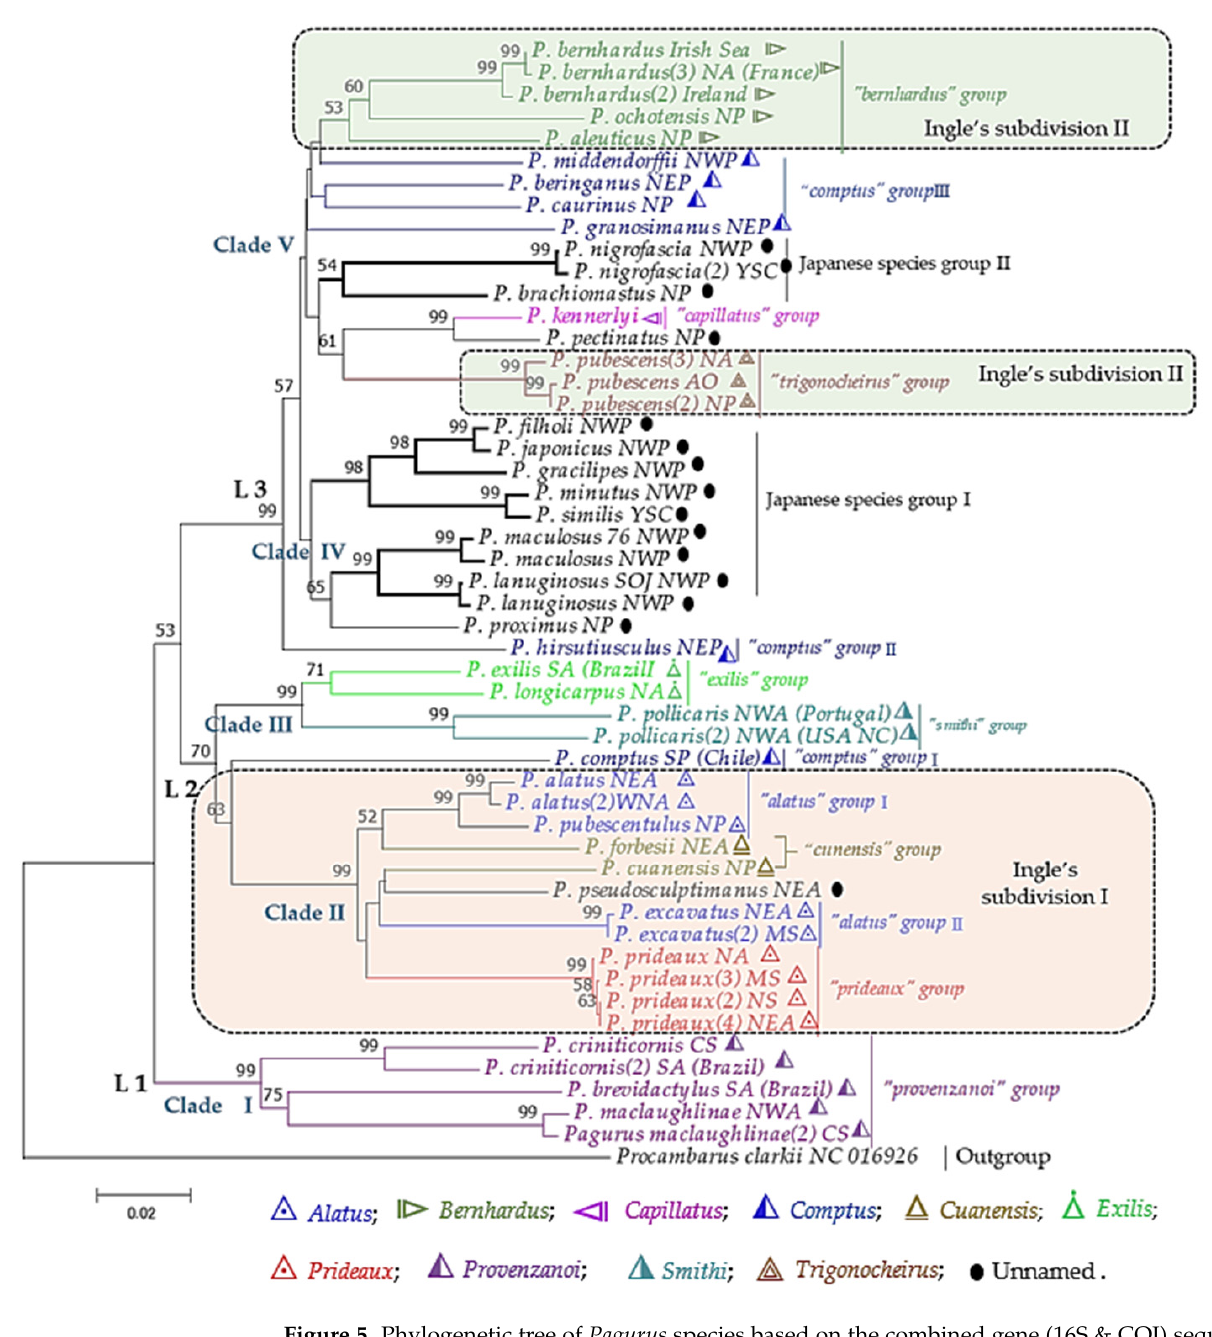
Figure 5. Phylogenetic tree of Pagurus species based on the combined gene (16S & COI) sequence inferred with the maximum-likelihood (ML) method using GTR + G + I model. Branch lengths are proportional to inferred nucleotide substitutions. Numbers at nodes represent bootstrap value in percentages; value below 50% are not shown. One concatenated sequence set from a species was included per location. Sampling locations included Arctic Ocean (AO), North Sea (NS), North Atlantic (NA), northeast Atlantic (NEA), northwestern Atlantic (NWA), Caribbean Sea (CS), Mediterranean Sea (MS), Gulf of Mexico (GoM), South Atlantic (SA), southwest Atlantic (SWA), North Pacific (NP), East Pacific (EP), northeast Pacific (NEP), northwest Pacific (NWP), southeast Pacific (SEP), Yellow Sea China (YSC), Yellow Sea South Korea (YSSK), East China Sea (ECS), South China Sea (SCS), Sea of Japan (SOJ), and Indian Ocean (IO). Different colors represent the morpho-based species groups.